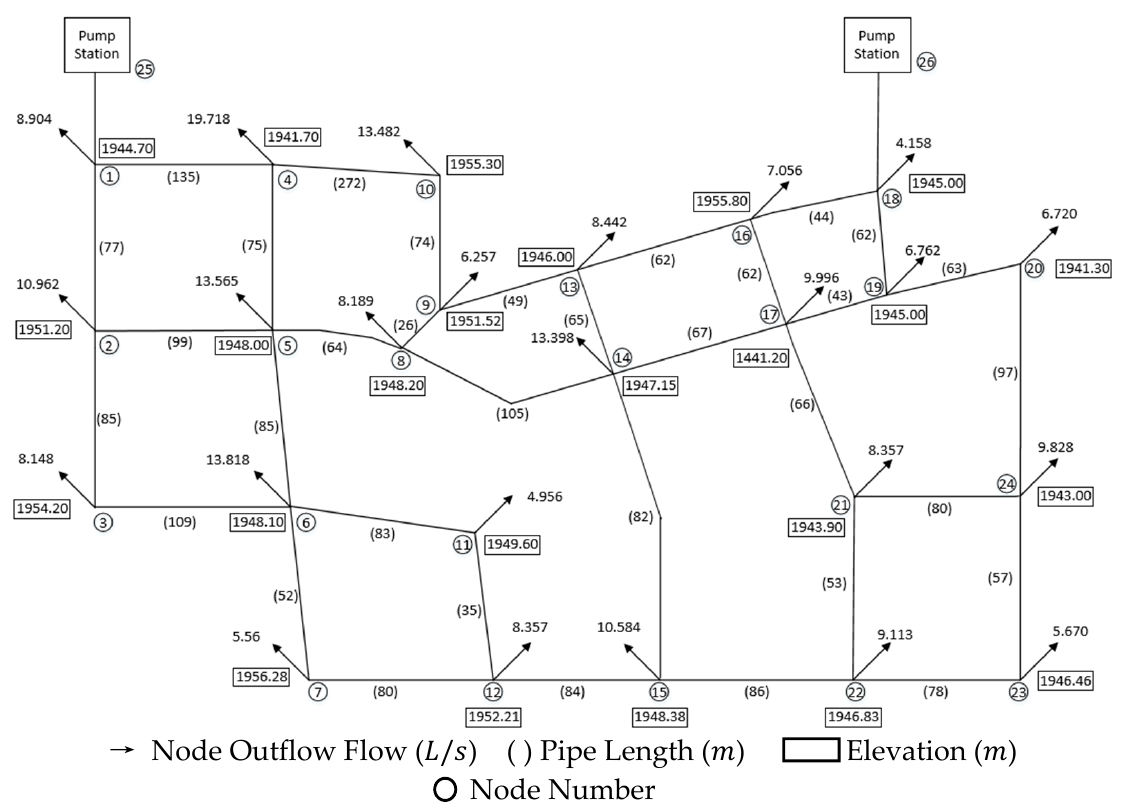
Figure 8. Water distribution network layout of the multi pump station project.